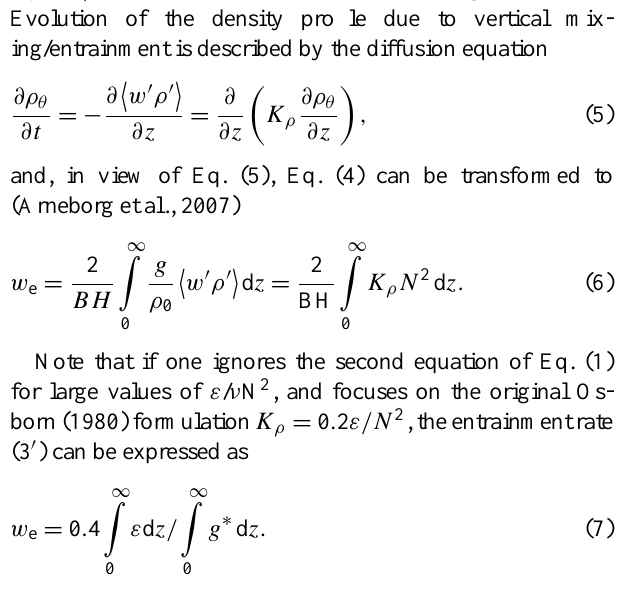
Fig. 5. Vertical profiles of modulus | V |and direction ϕ of current velocity, salinity S , potential temperature θ and density ρ θ , the Richardson number Ri , and the dissipation rate ε in the DSO plume at stations (a) 120 and (b) 158.